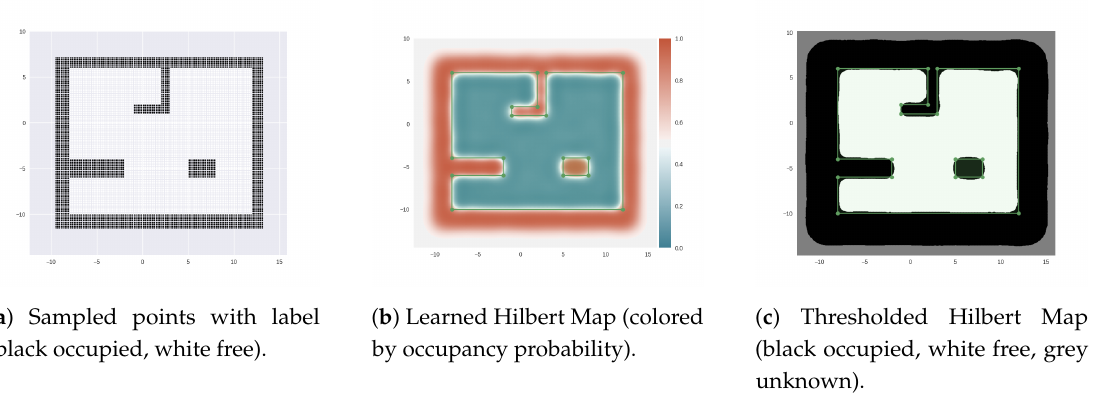
Figure 6. ( a ) Sampled points from the simulated scenario; ( b ) Learned HM for TBN; ( c ) Learned HM thresholded at p ( occ ) > 0.5 for the occupied, p ( occ ) < 0.5 for free, and p ( occ ) = 0.5 for unknown,